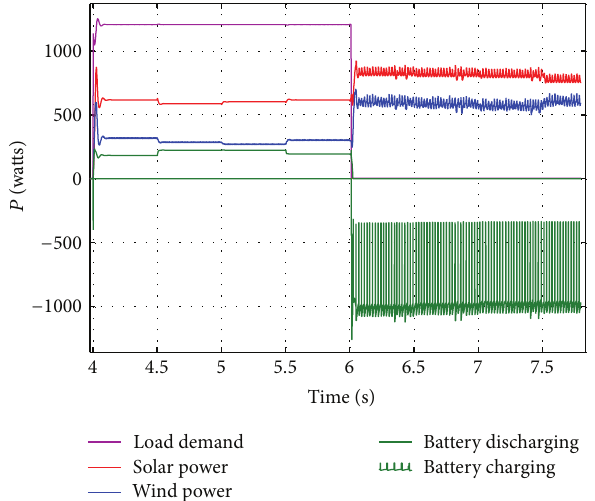
Figure 23: Controller duly discharges the battery (as SOC is more than 40%) along with the instantaneous power delivered by solar PV panel and WTG to meet the constant LD.